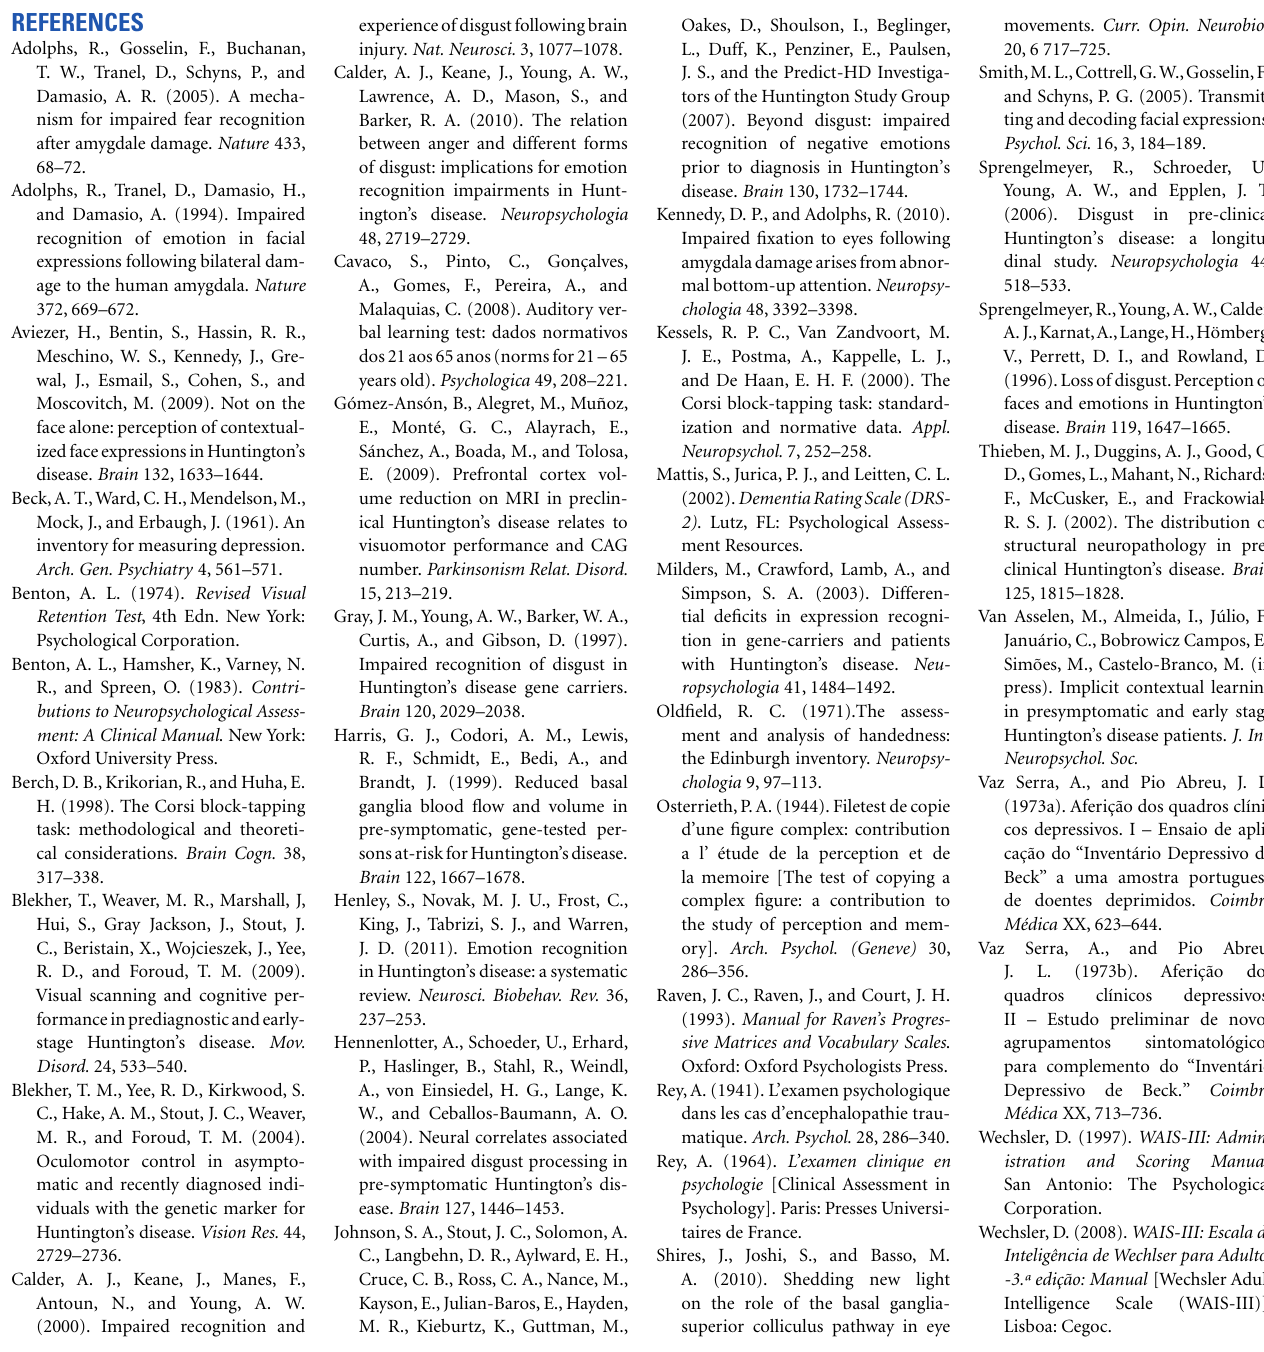
d’une figure complex: contribution a l’ étude de la perception et de la memoire [The test of copying a complex figure: a contribution